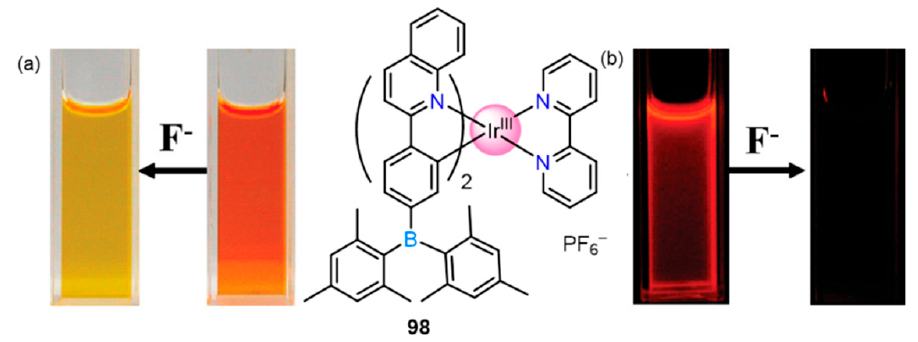
Figure 15. Structure of Ir(III) complex 98 and ( a ) naked eye color change; ( b ) emission color observed under a UV lamp in the absence and presence of F − . [Adapted from reference [116]; Copyright © 2023, American Chemical Society] .